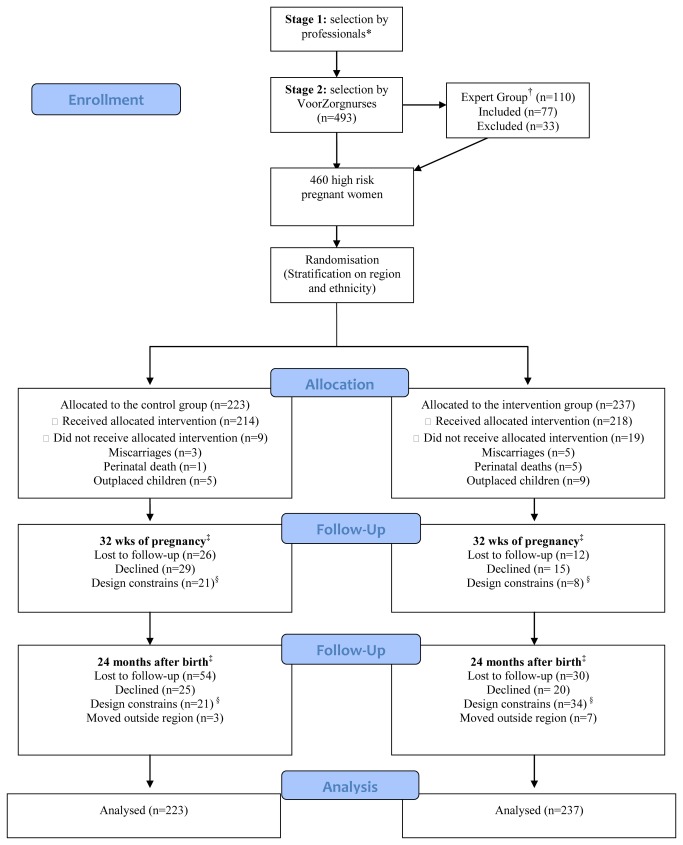
Flow of the participants through the study.*General practitioners, gynecologists, midwives, street corner workers (comparable to social workers) etc. The number of women for stage 1 is unknown; the pilot studies indicate that the VoorZorg nurses selected approximately 50% of them.
† Only VoorZorg nurses could refer to the expert group, which settles arguments around inclusion .
§ No interviewer available, start-up problems RCT.
‡ Numbers were only used for the 24-month analyses with imputated values.